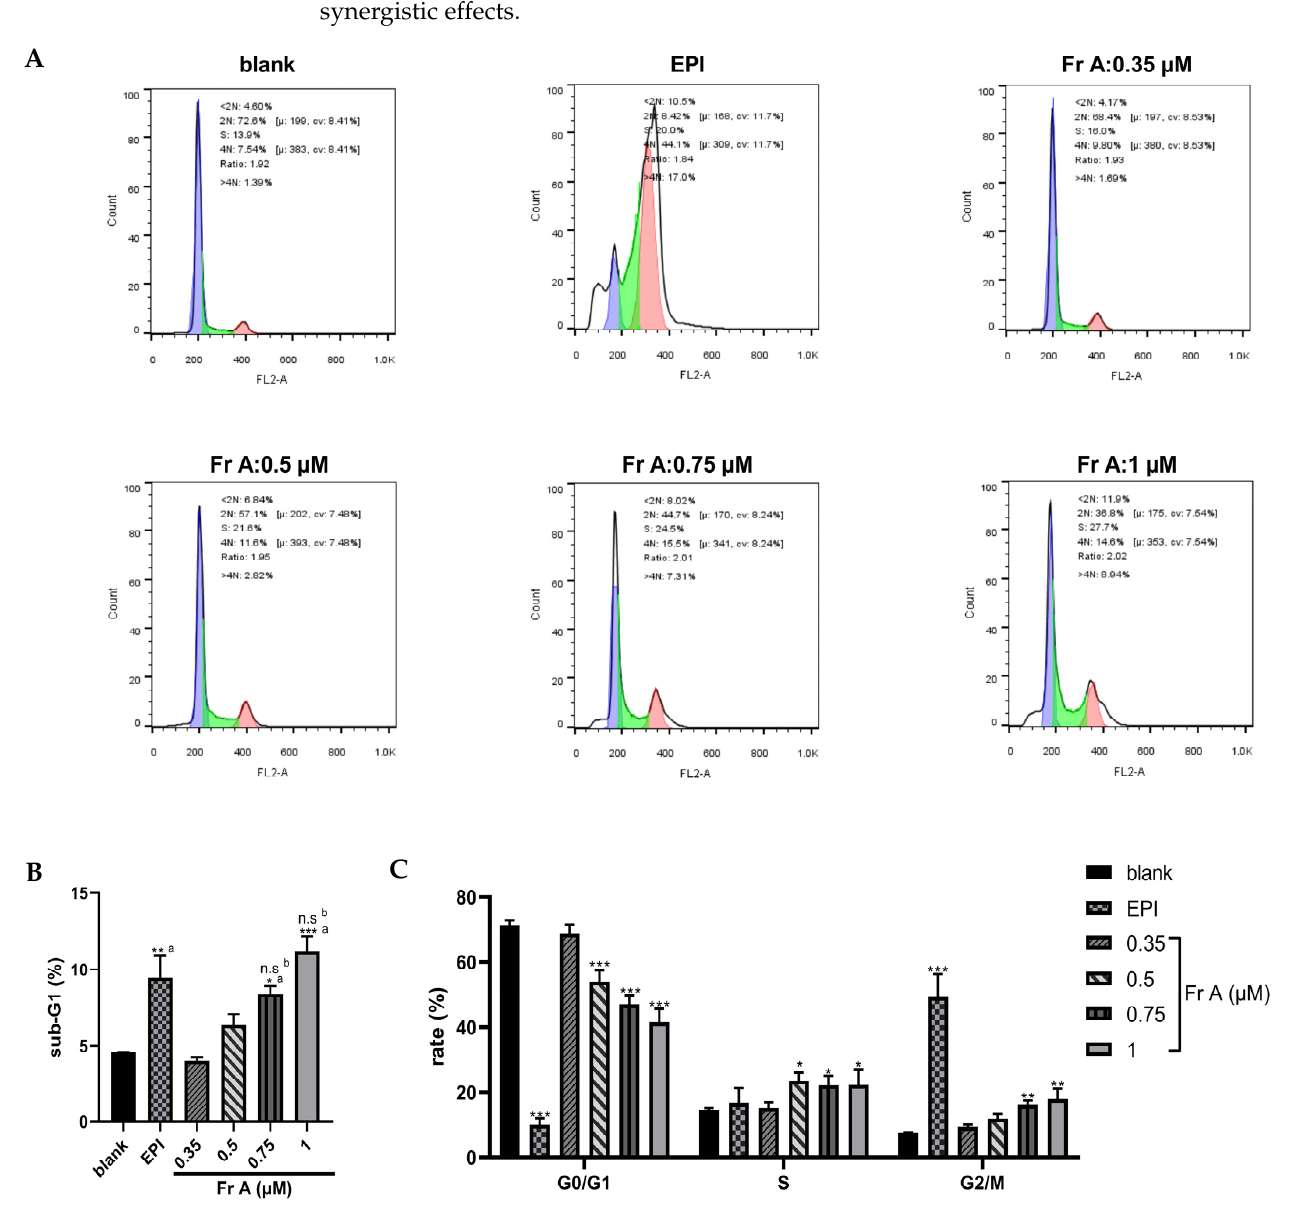
Figure 2. Effects of Frondoside A (Fr A) on cell cycle in bladder cancer cells. Cells were treated with increasing concentrations of Frondoside A for 48 h, with EPI (10 µ M) as positive control. The distribution of cell cycle ( A – C ). Data are expressed as mean ± S.E.M. * Significantly different at p < 0.05. ** Significantly different at p < 0.01. *** Significantly different at p < 0.001. n.s (not significant). “a” stands for versus blank control; “b” stands for versus EPI (10 µ M). The results of cell migration (i.e., cell scratch experiment) showed that the drug combinations of Frondoside A (0.5 µ M) and CpG-ODN (0.001–1 µ M) also resulted in more pronounced inhibition of cell migration than both EPI (10 µ M, positive control) and Frondoside A (0.5 µ M) alone (Figure 4C) at both 12 h and 24 h time points. The effects of the combinations of Frondoside A and CpG-ODN on cell cycle distribution and induce cell apoptosis were also studied. The combinations did not induce significant alteration in the cell cycle and cell apoptosis; as shown in Figure 5, it is clear that while combinations of Frondoside A (0.5 µ M) and CpG-ODN (0.001–1 µ M) had no significant effects on cell